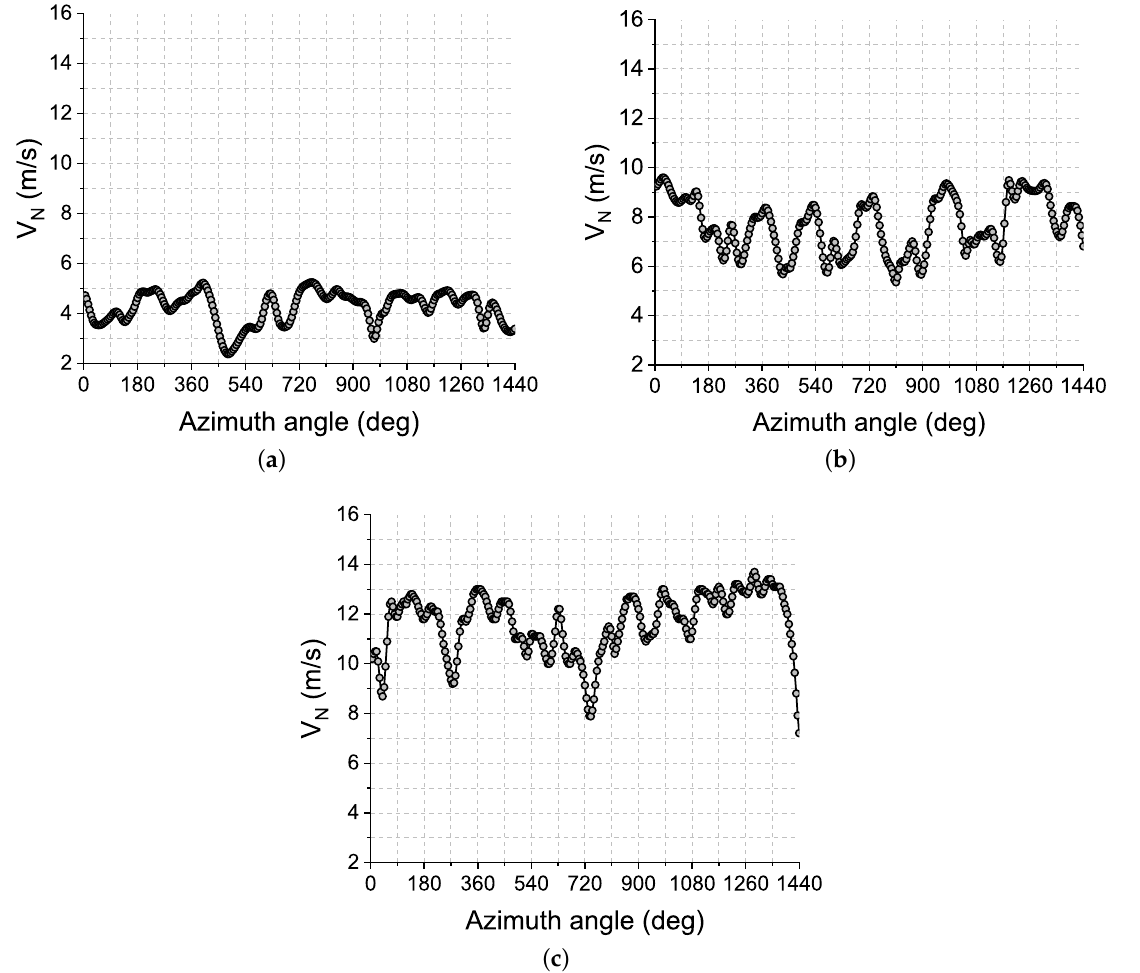
Figure 7. Variation of V N respecting the blade azimuth angle with stable inlet flow. ( a ) Case 1 (Stable 5m/s). ( b ) Case 2 (Stable 9m/s). ( c ) Case 3 (Stable